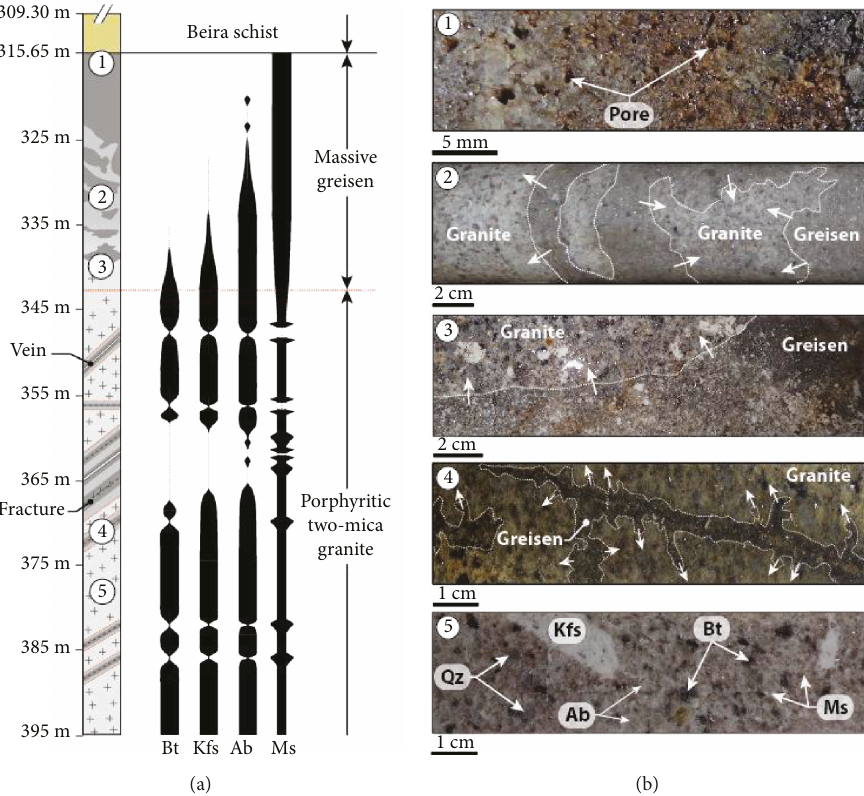
Figure 2: (a) Drill hole SCB2 showing the vertical mineral zoning of the greisen alteration. (b) Macroscopic textural characteristics of (1) facies of the most altered greisen displaying a well-developed porosity, (2) quartz-muscovite greisen in which it is possible to observe pieces of less altered granite (white dashed lines correspond to the alteration front and white arrows to the expected direction of propagation), (3) propagation of the pervasive greisenization toward the Panasqueira granite, (4) propagation of alteration from the fracture in the deeper part of the drill hole, and (5) the porphyritic two-mica granite of Panasqueira. Mineral abbreviations from Whitney and Evans [45]. Ab: albite; Bt: biotite; Kfs: K-feldspar; Ms: muscovite; Qz: